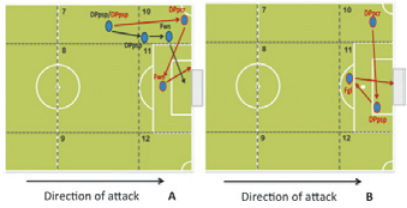
Figure 3. Illustration of the offensive patterns that resulted in a wide shot (A) and in goals scored (B) in the Maintenance of Ball Possession Game. See Table